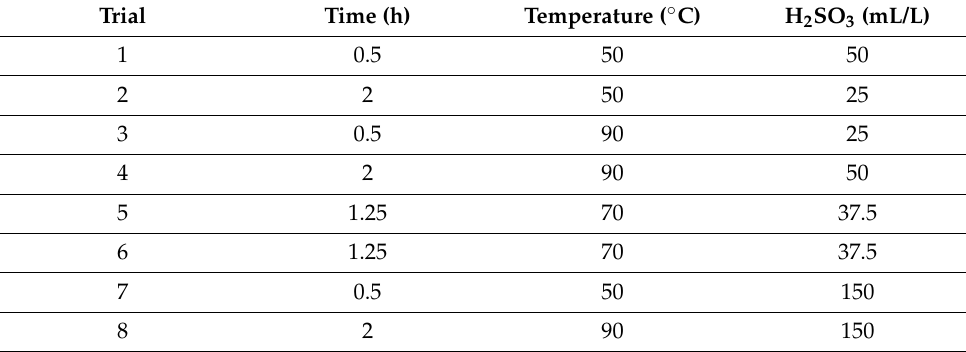
Table 6. Test conditions for sulfurous acid